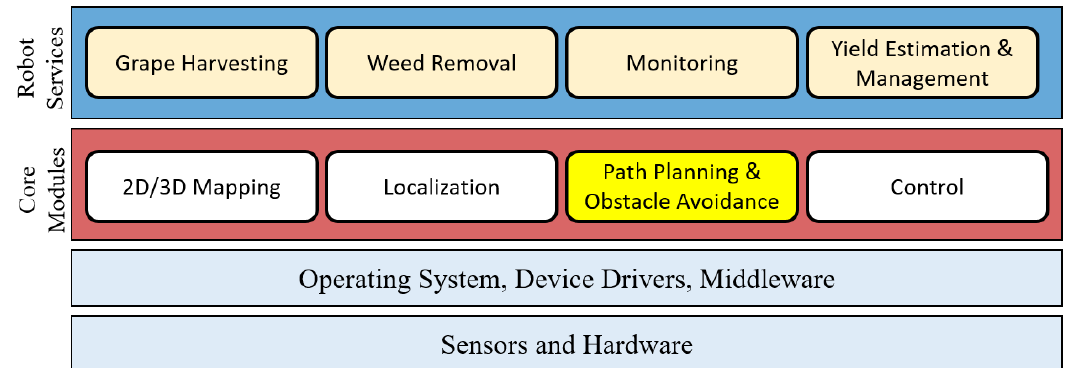
Figure 2. Standing of proposed research (yellow block) in Vineyard robots. Path planning and obstacle avoidance is a core module of mobile robots that supports top-level applications such as harvesting, weed removal, monitoring, and